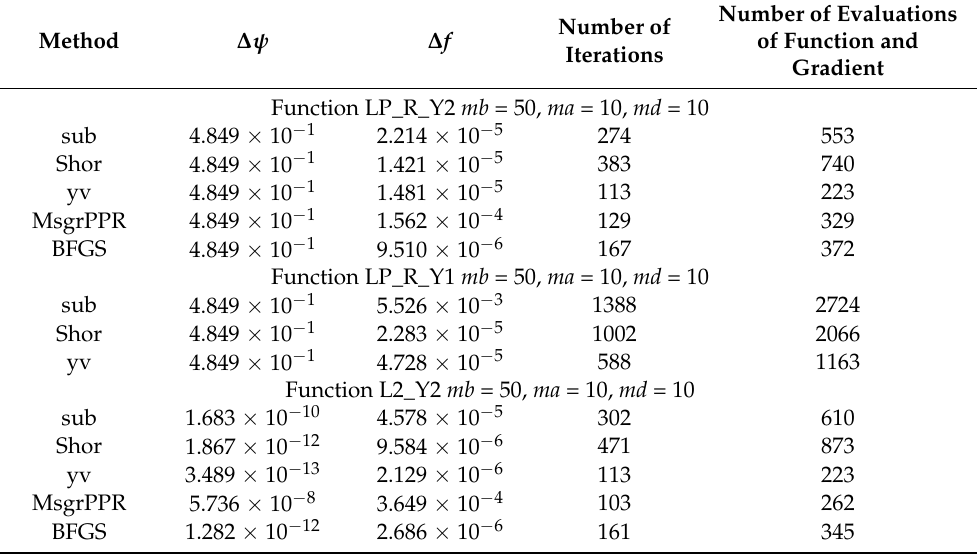
Table 4. Results of calculations for dimensions n = 1000, m = 100 with mb =